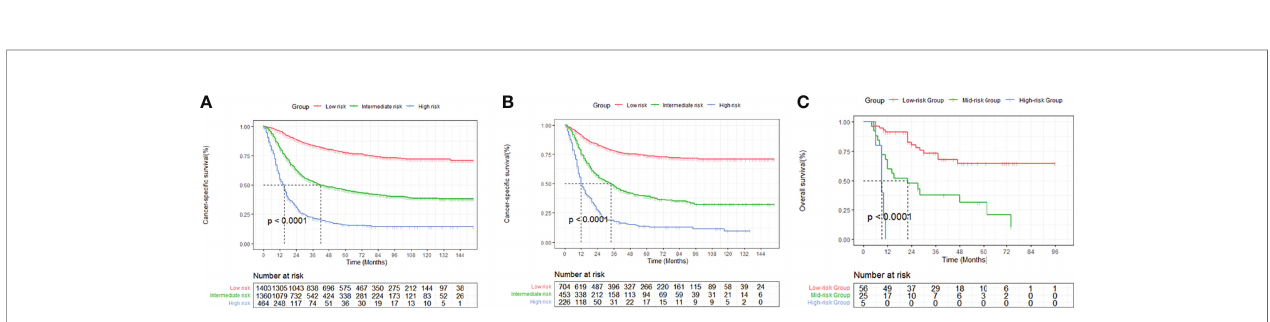
FIGURE 6 | Kaplan-Meier curves of cancer-speci fi c survival for patients in the low-, intermediate-, and high-risk groups in the primary cohort (A) , the internal validation cohort (B) and the external validation cohort (C)